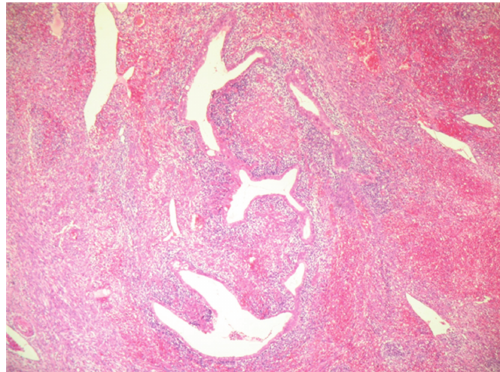
Figure 2: Endocervial glands surrounded by a cellular stroma with periglandular condensation.